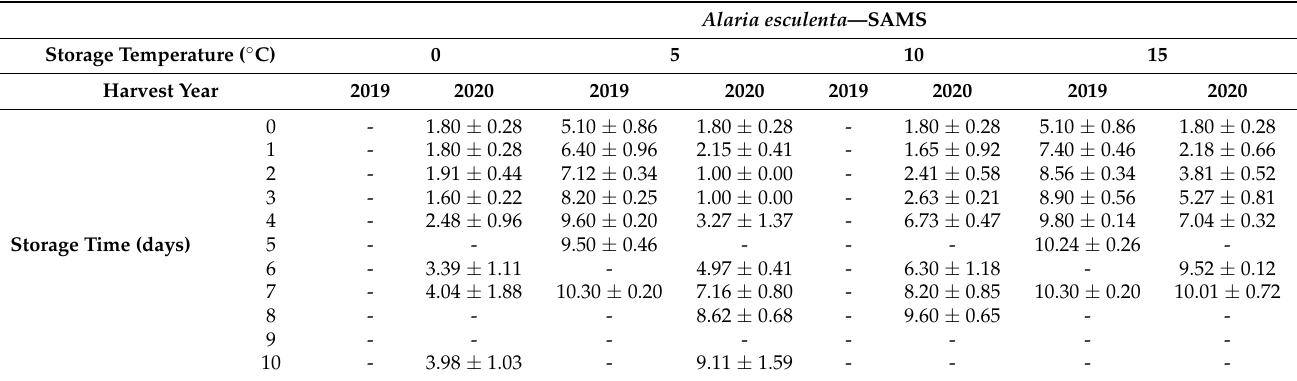
Table 3. Microbial populations throughout the storage of seaweed harvested from SAMS (Scotland) in two different